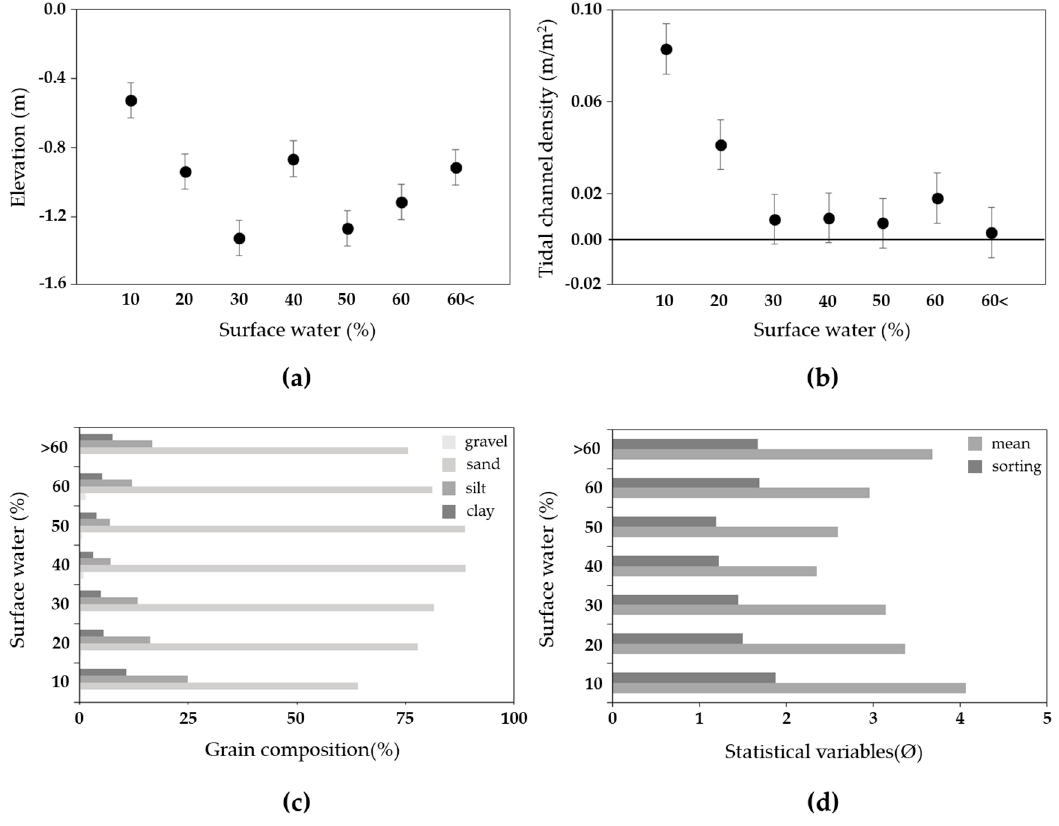
Figure 8. Correlations among topography, sediment properties according to the surface water; ( a , b ) indicate the relationships among elevation, tidal channels, and surface water, and ( c , d ) indicate the relationships among mud content, mean and sorting values, and surface water. The error bar is the standard error, which is the standard deviation of each category divided by the number of samples (Error bar = standard deviation/ √ number of samples) .